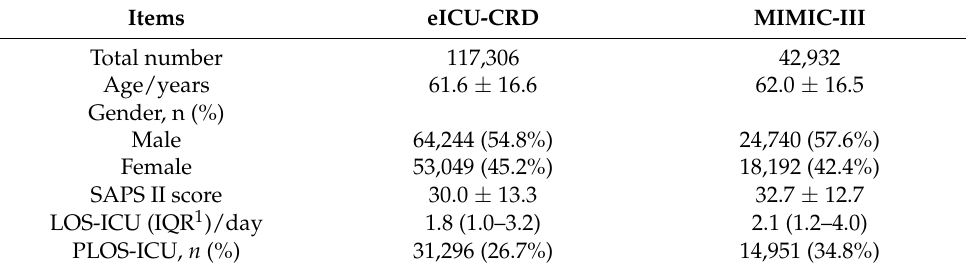
Table 3. Characteristics of ICU patients in eICU-CRD and